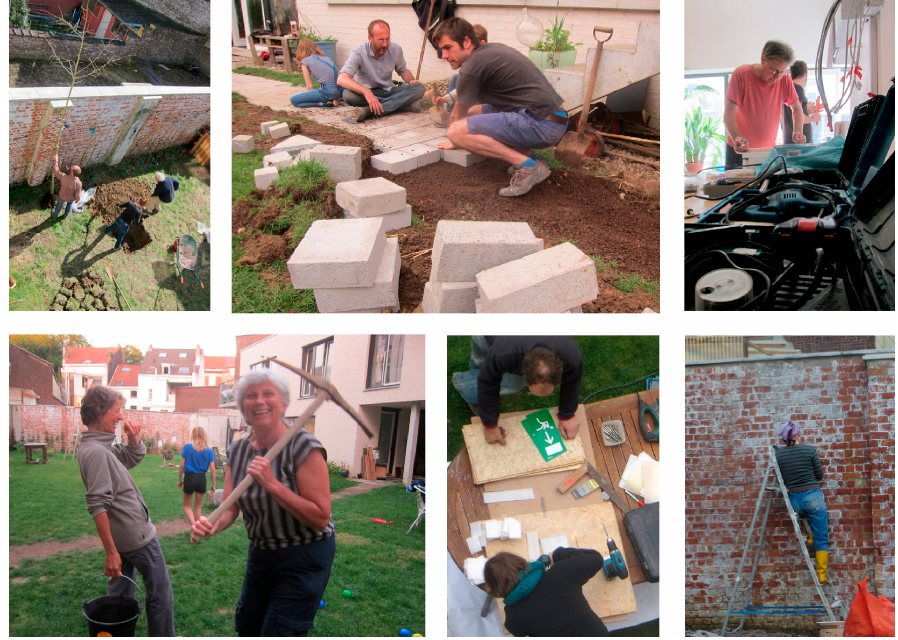
Figure 12. The ‘Minga’ collective working day (http://www.echappee.collectifs.net, accessed on 11 June 2019).